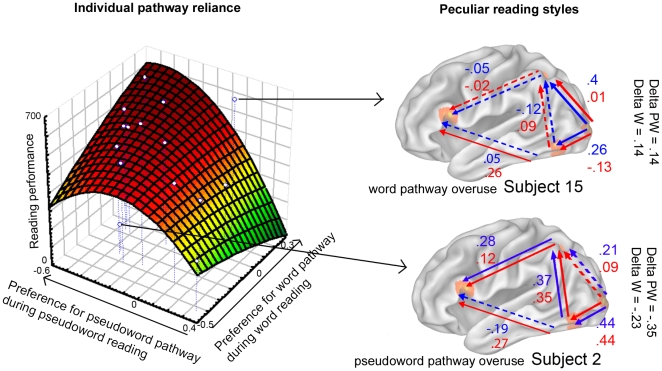
Group and individual pathway reliance.Left Panel: Group trade-off between preferences (delta values) for the word pathway vs. the pseudoword pathway resulting in efficient (dark-red) or deficient (yellow-green) reading performance outside the scanner (CTL index). Right Panel: Subjects with nonconformist reading styles during word (blue) and pseudoword (red) reading which predict their highly-efficient (subject 15) and inefficient (subject 2) reading performance.